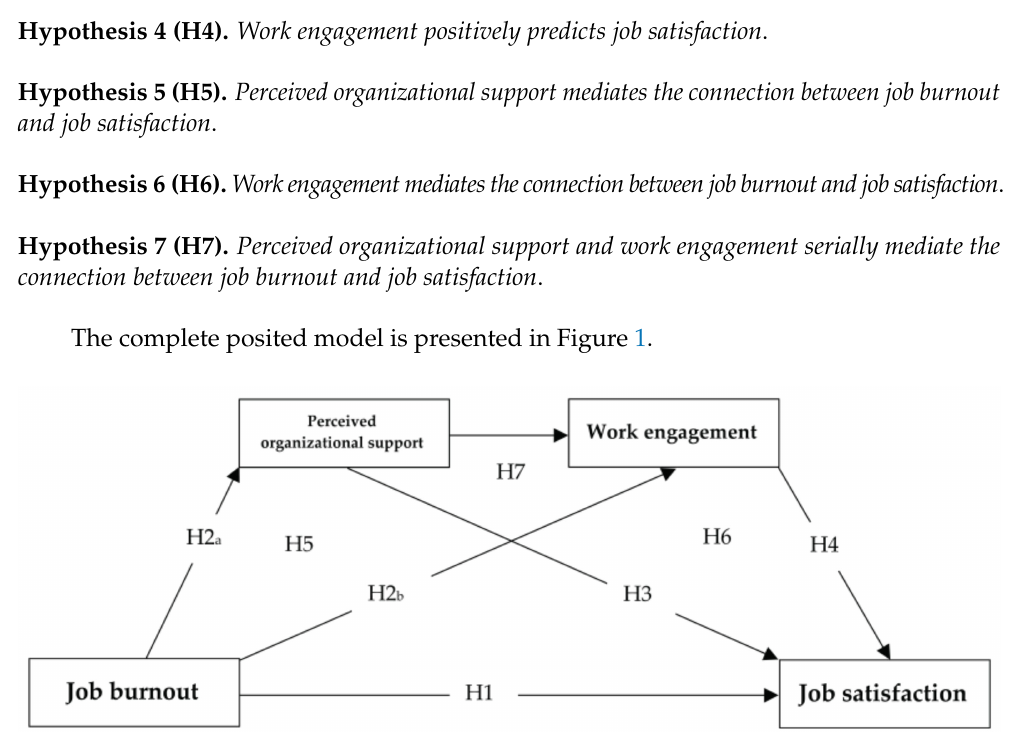
Figure 1. Hypothesized research